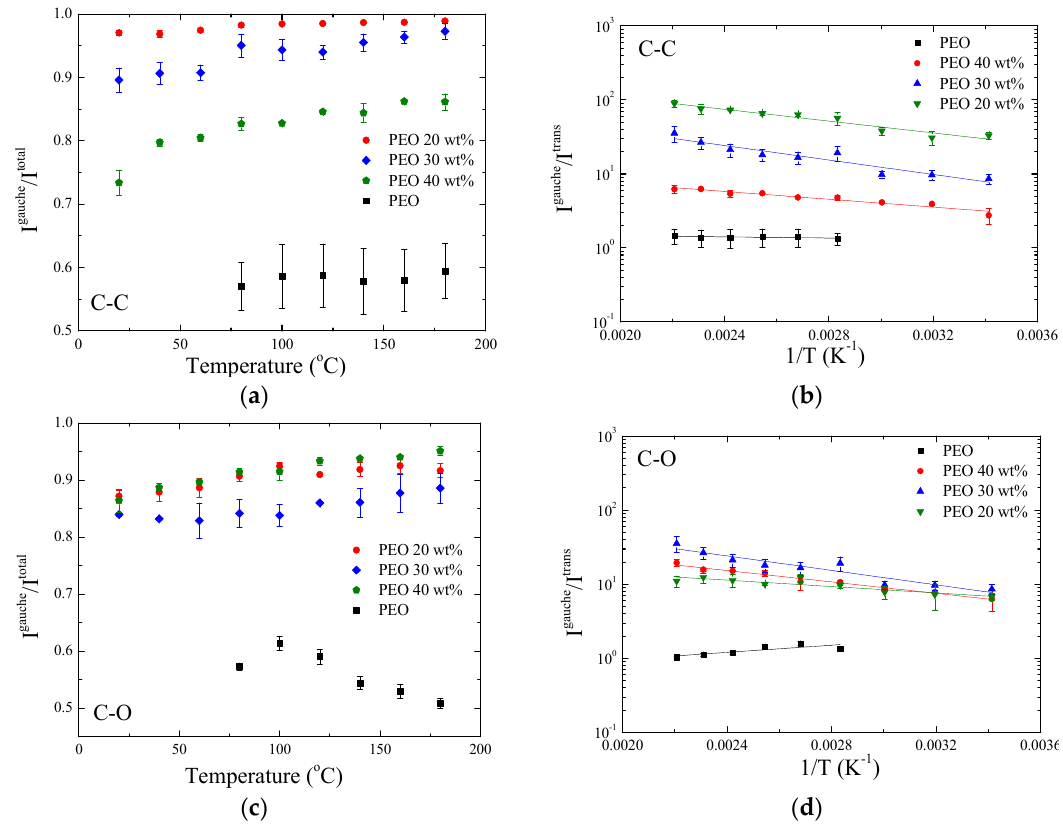
Figure 5. Temperature dependence of the intensity ratio ( a ) I 1350 /( I 1325 + I 1350 ) and ( c ) I 1300 /( I 1285 + I 1300 ) signifying the ratio I gauche /I total for pure PEO and nanocomposites of varying compositions. In the right part the ratios ( b ) I 1350 / I 1325 and ( d ) I 1300 I 1285 signify the ratio I gauche /I trans in an Arrhenius representation for the respective samples.